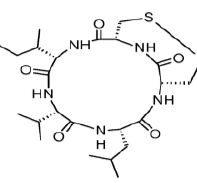
Figure 3. Structure of malformin E